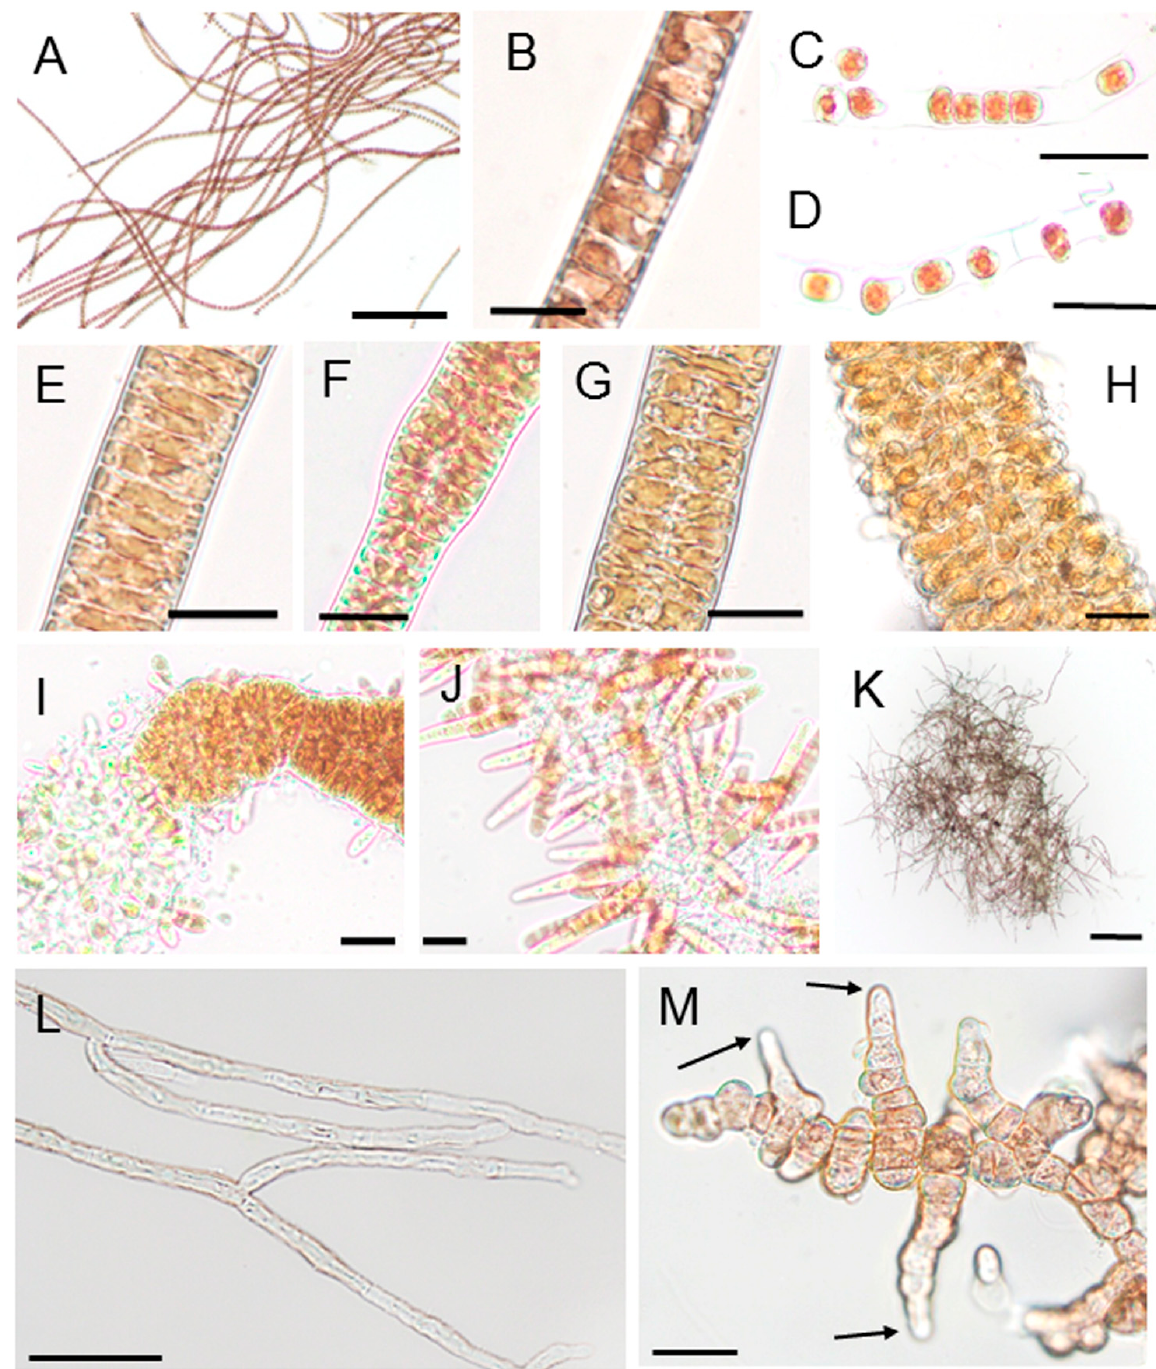
Figure 2. Morphological characteristics of thalli, conchocelis filaments, and conchosporangia of ‘ Bangia ’ sp. ESS2: ( A , B ) Filamentous structure of gametophytic thalli; ( C , D ) Release of asexual spores from uniseriate thalli; ( E – H ) Asexual sporangium development, including doubling of the width of the vegetative cells, vertical cell division to form biseriate thalli, and random cell division to form multiseriate thalli; ( I ) Release of asexual spores from the tip of a multiseriate thallus; ( J ) Development of gametophytic thalli on a parental thallus without spore release; ( K ) Aggregate of conchocelis filaments, which appear black; ( L ) Magnified view of conchocelis filaments with branches; ( M ) Conchosporangia produced on conchocelis filaments. Many branches were produced in conchosporangia, unlike conchocelis filaments, which formed branches only infrequently; the pointed tip cells are indicated by arrows. Scale bars: 25 μ m for A–J and M, 200 μ m for K, 50 μ m for L.